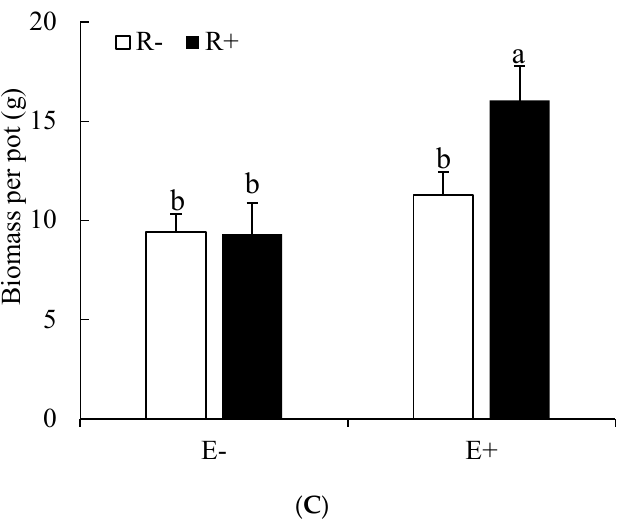
Figure 3. ( A – C ) The influence of endophytic fungi and rhizobia on the biomass of tall fescue. E − , endophyte-free tall fescue, E+, endophyte-infected tall fescue; AMF+, AMF-inoculated; AMF − , AMF-free; R+, rhizobia-inoculated; R − , rhizobia-free. Different small letters indicate significant differences between treatments ( p < 0.05).